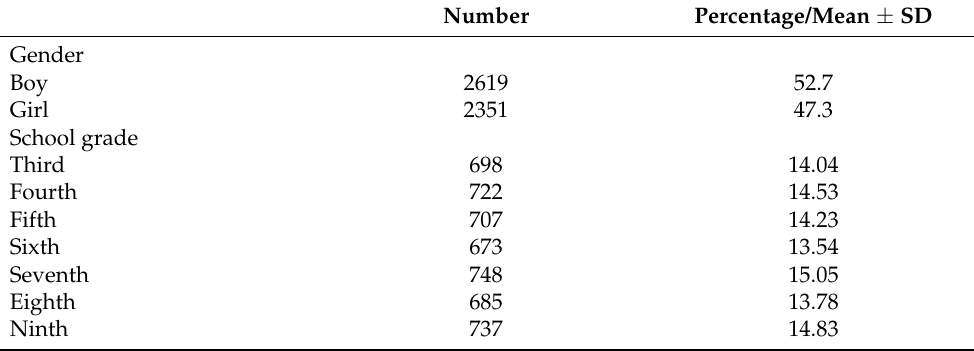
Table 1. The socio-demographic characteristics of the children participants.